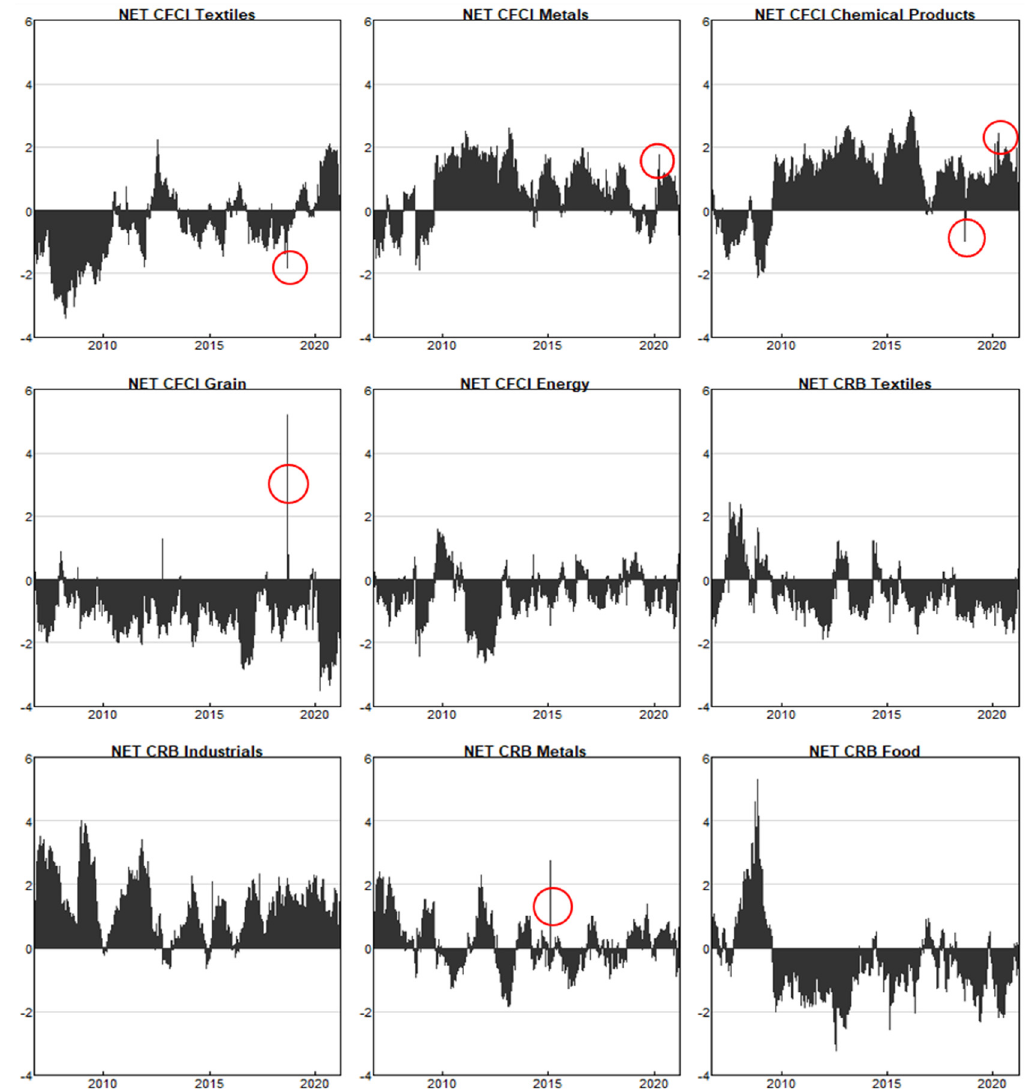
Figure 4. The net volatility spillover diagram of rolling samples.